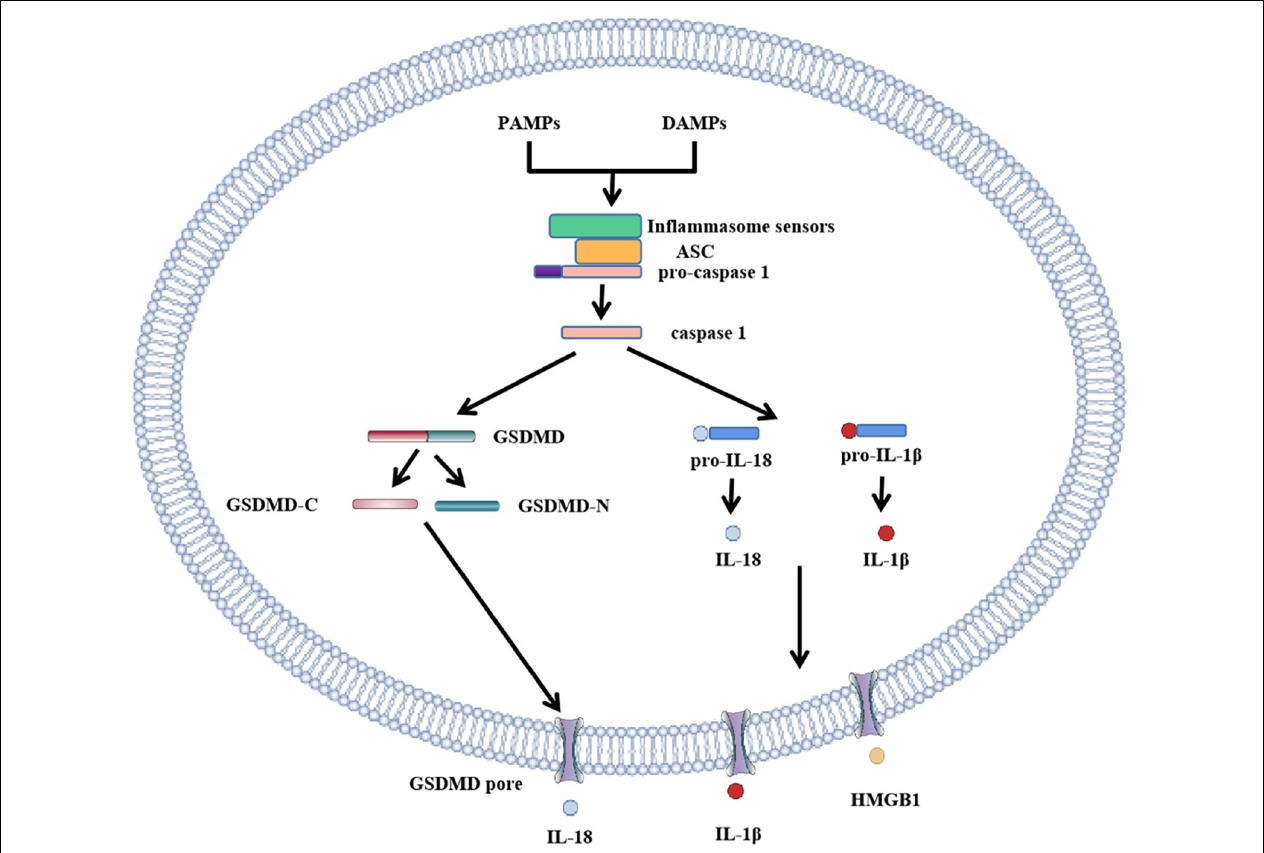
FIGURE 1 | Role of GSDMD in canonical inflammasome activation. The canonical pathway of pyroptosis. PAMPs or DAMPs bind to inflammasome to activate caspase-1, cleaving GSDMD to form GSDMD-C and GSDMD-N. GSDMD-N cluster and bind to the plasma membrane to form GSDMD pores. Simultaneously